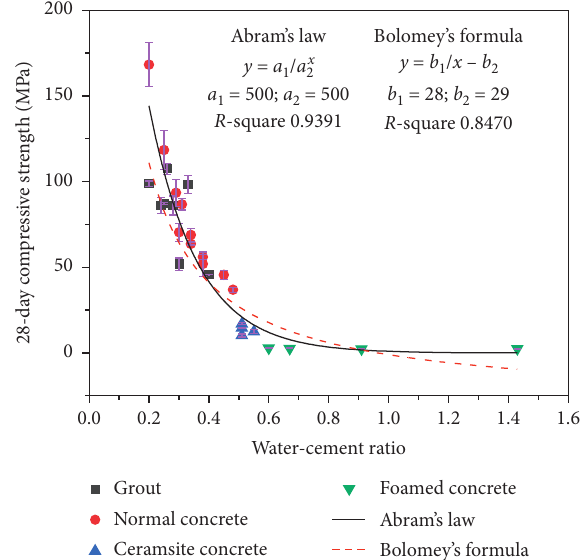
Figure 7: Simulations of Abrams’ law and Bolomey’s formula for foamed concrete.